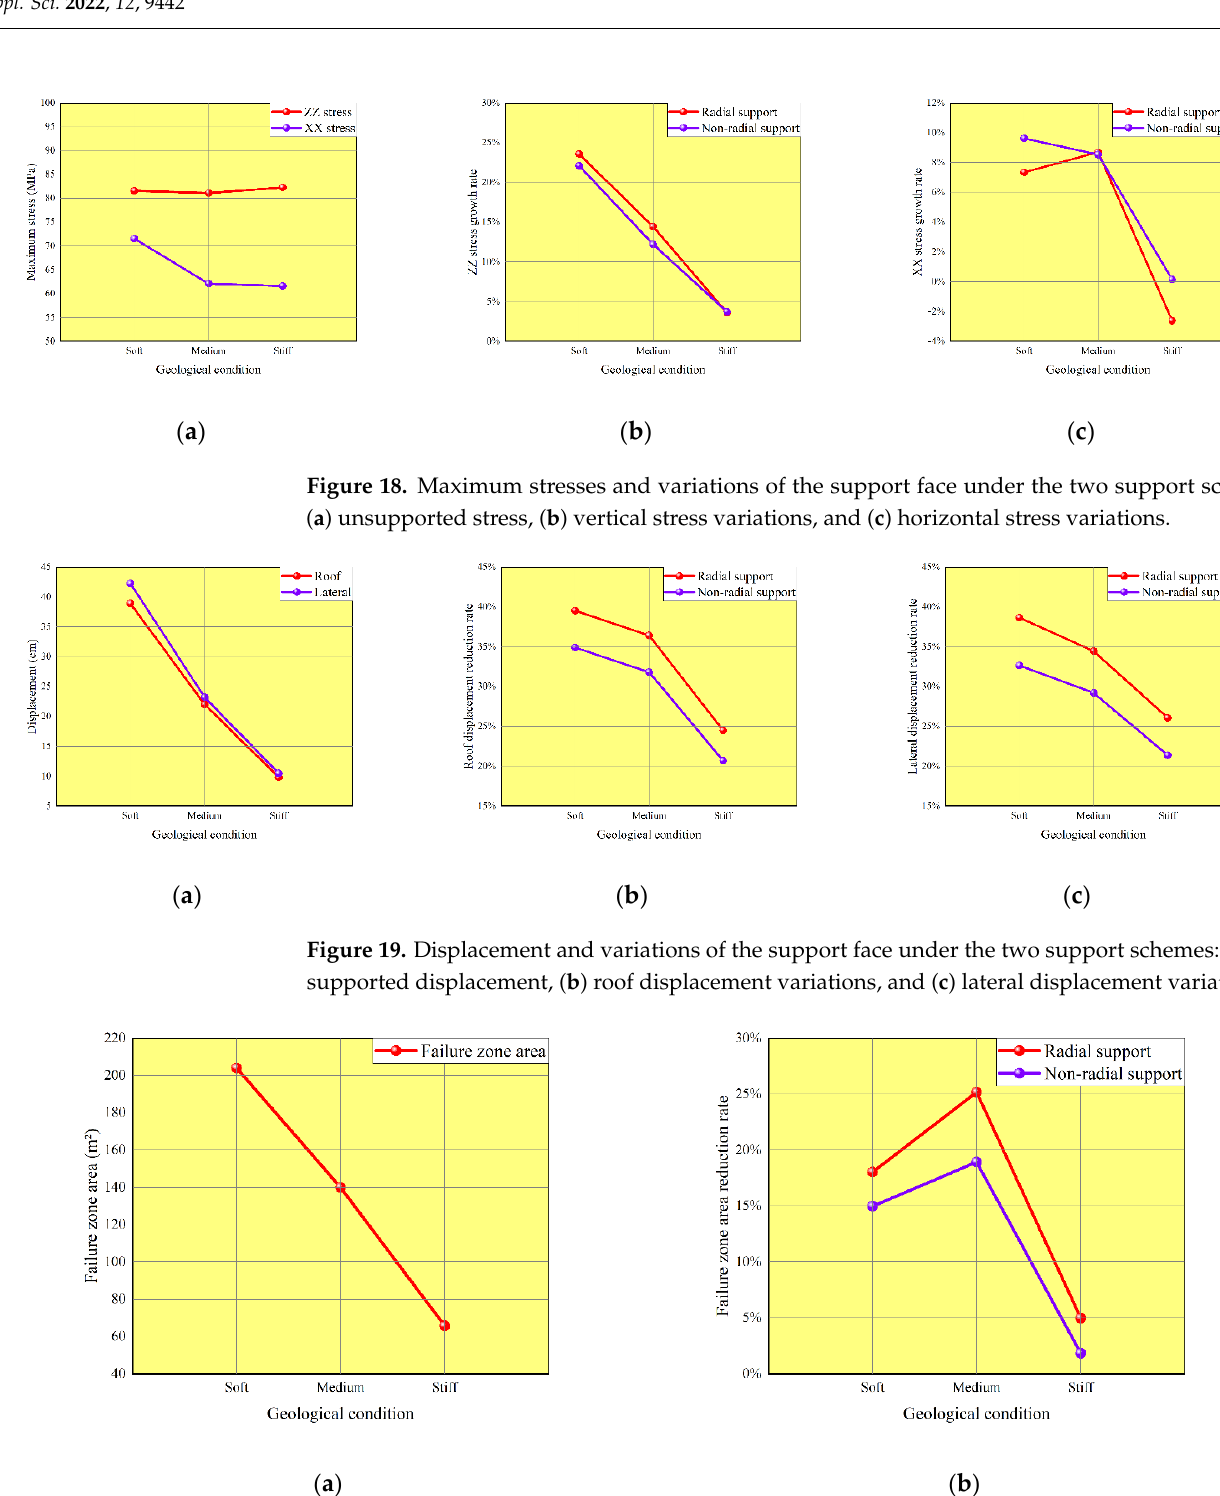
Figure 20. Failure zone area and variations of the support face under the two support schemes: ( a ) unsupported failure zone area and ( b ) failure zone are variations.